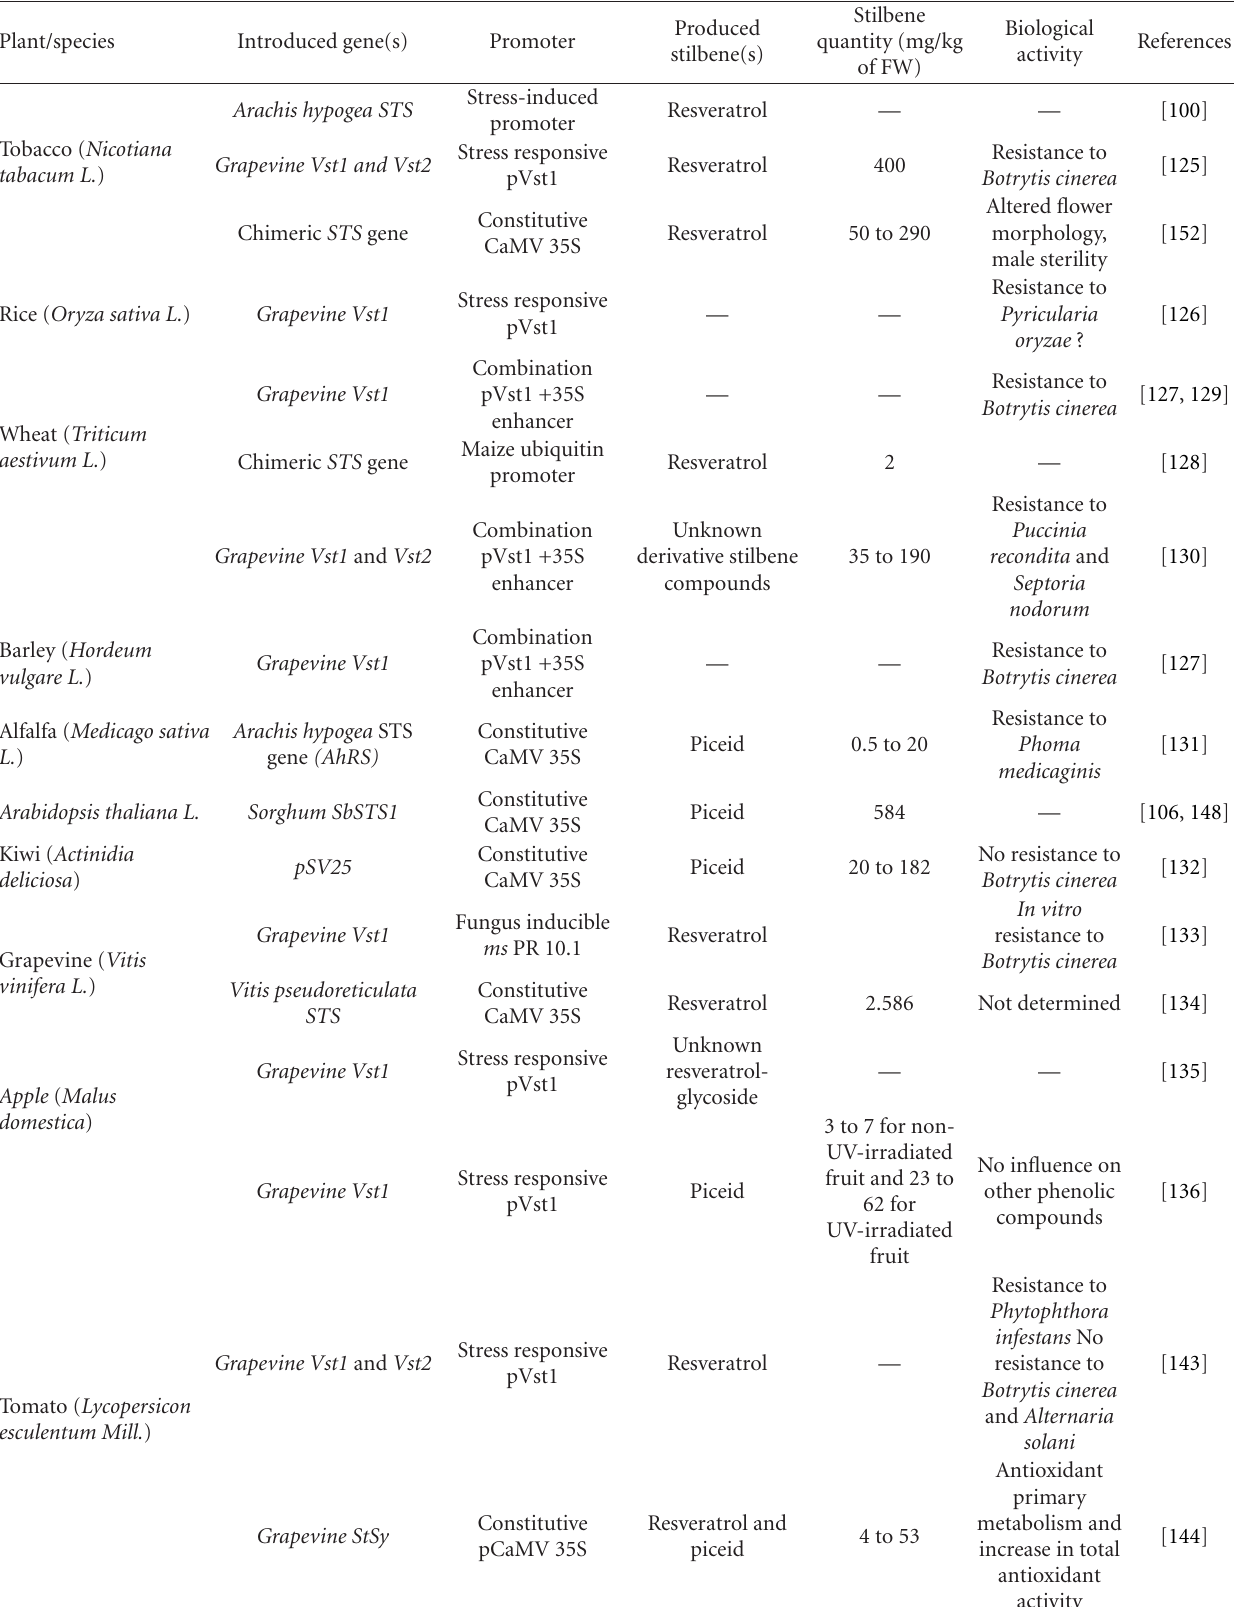
Table 2: Metabolic engineering of stilbene synthase in plants, and resulting e ff ects on stilbene levels, resistance to pathogens, and antioxidant